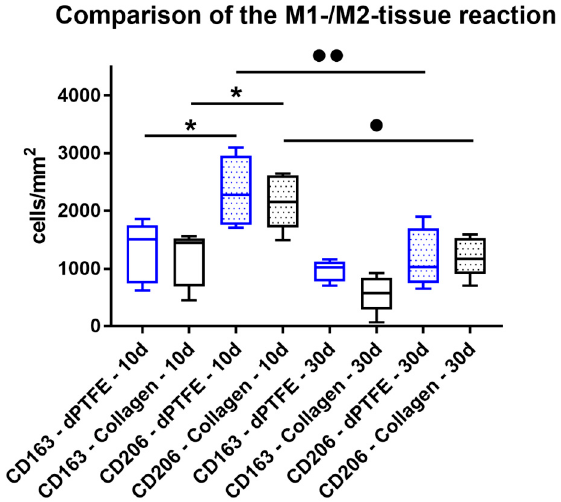
Figure 3. The results of the histomorphometrical analysis of the M1 and M2´macrophages within the implantation beds f both materials (*/ p < 0.05 and p < 0.01).